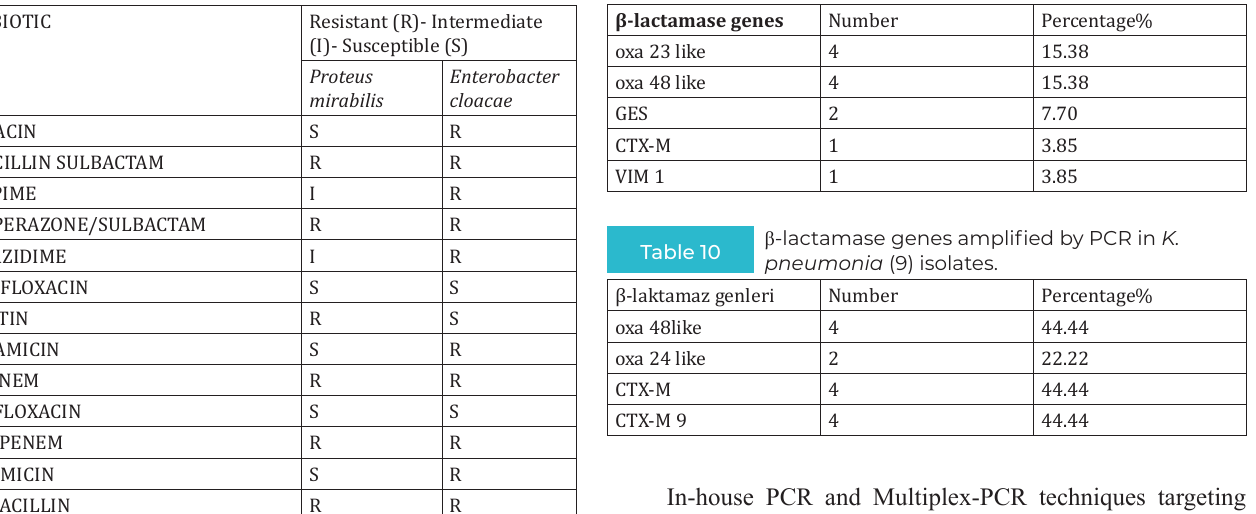
β -lactamase genes amplified by PCR in P. aeruginosa (26) isolates